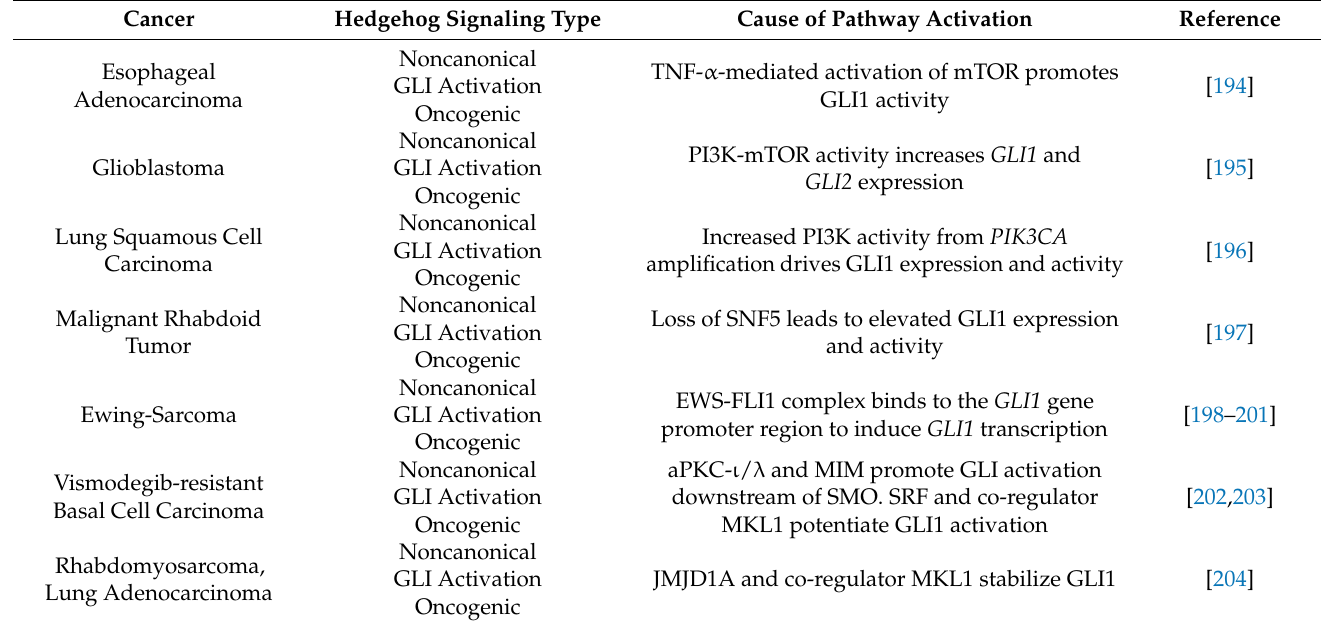
Table 2. List of cancers with noncanonical GLI transcription factor